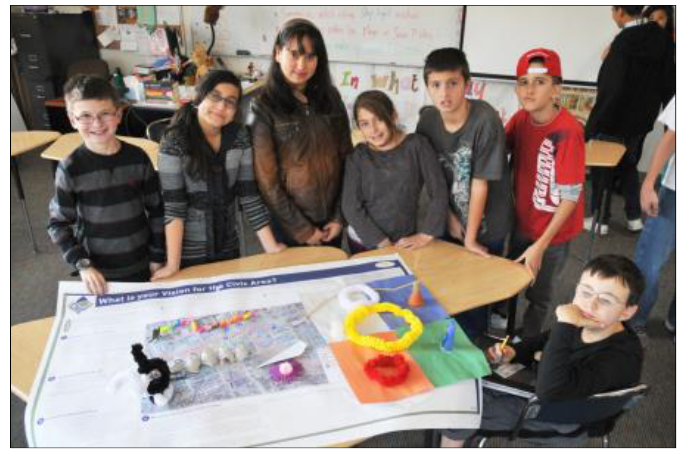
Figure 11. Casey Middle School students showing their “City as Play” method with animal sculpture (photo courtesy of Lynn M.